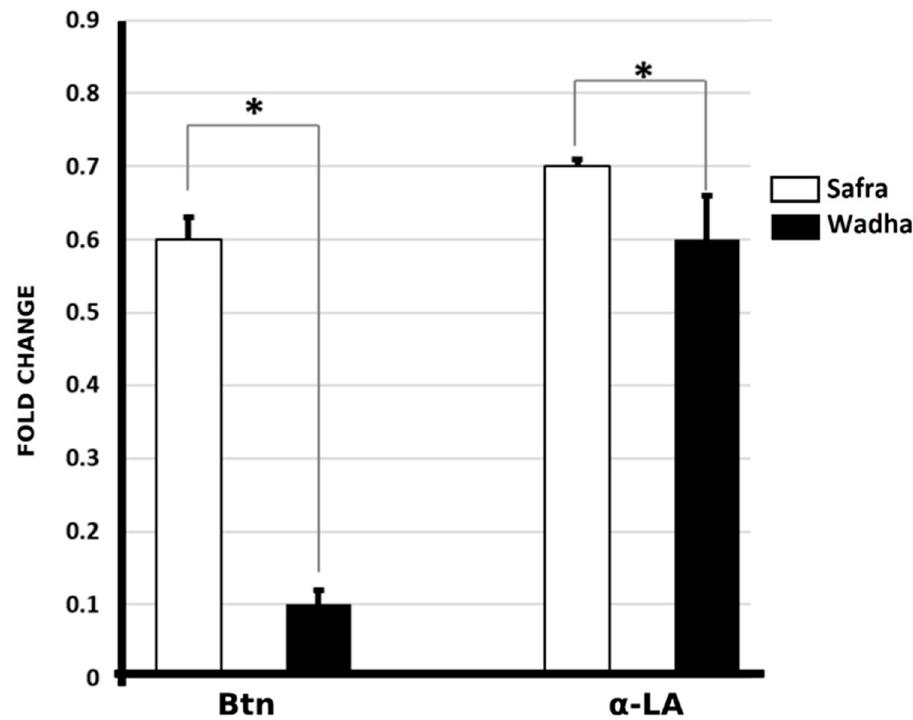
Figure 6. ELISA immunoassay results showed significant differences in the levels of Btn proteins between Safra and Wadha breeds (0.6 ± 0.03 vs. 0.10 ± 0.22, p ≤ 0.01) with a fold change of 2.1, up in Safra similar to the DIGE results. This was also seen in the levels of α -LA in Safra and Wadha (0.73 ± 0.01 vs. 0.61 ± 0.06, p < 0.01) breeds with a fold change of 1.2 up in Safra breed which was quite similar to the DIGE result. * p ≤